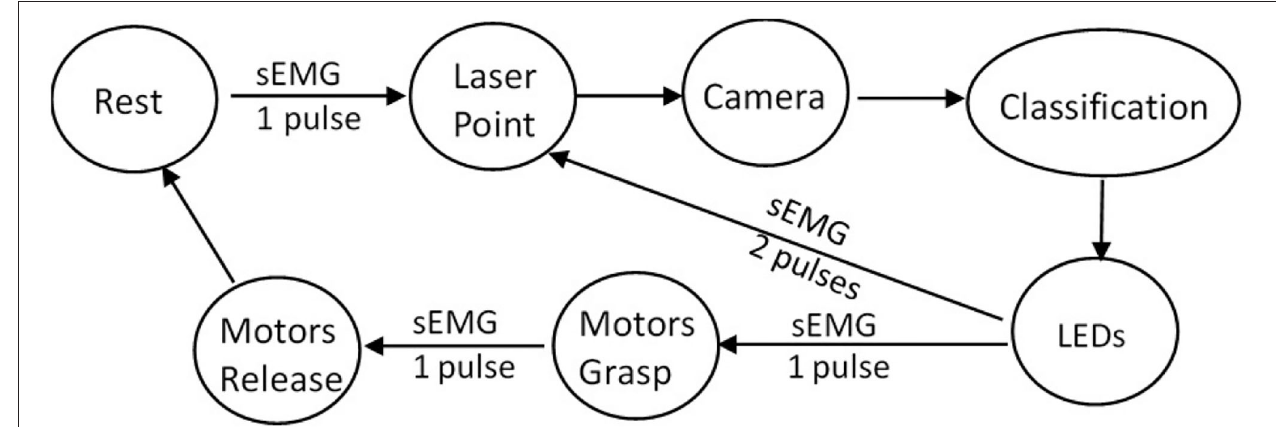
FIGURE 3 | Finite state machine diagram.